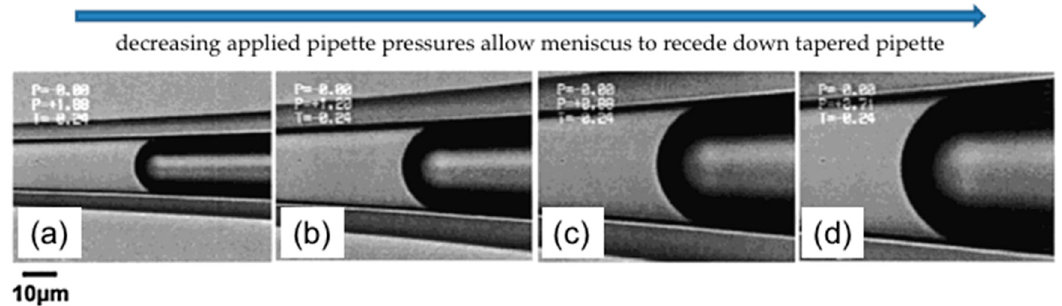
Figure 5. Microscope images of an air ‐ water surface inside a tapered micropipette. ( a ) The air ‐ filled micropipette was inserted into the surfactant solution under relatively high positive applied pipette pressure 18.8 kPa. The meniscus came to equilibrium such that the interface meniscus (diameter ~15 µ m) was close to pipette tip. ( b – d ) The applied positive pressure was then decreased to, ( b ) 12 kPa, ( c ) 8.8 kPa, and ( d ) 7.1 kPa respectively allowing the meniscus to recede down the tapered pipette to new equilibrium curvatures. In the experiment this is followed by a series of increasing pressures that move the meniscus back down the pipette and so is advancing. There was no hysteresis in the positions or contact angle for these receding or advancing contact angles. With permission from American Chemical Society [9].